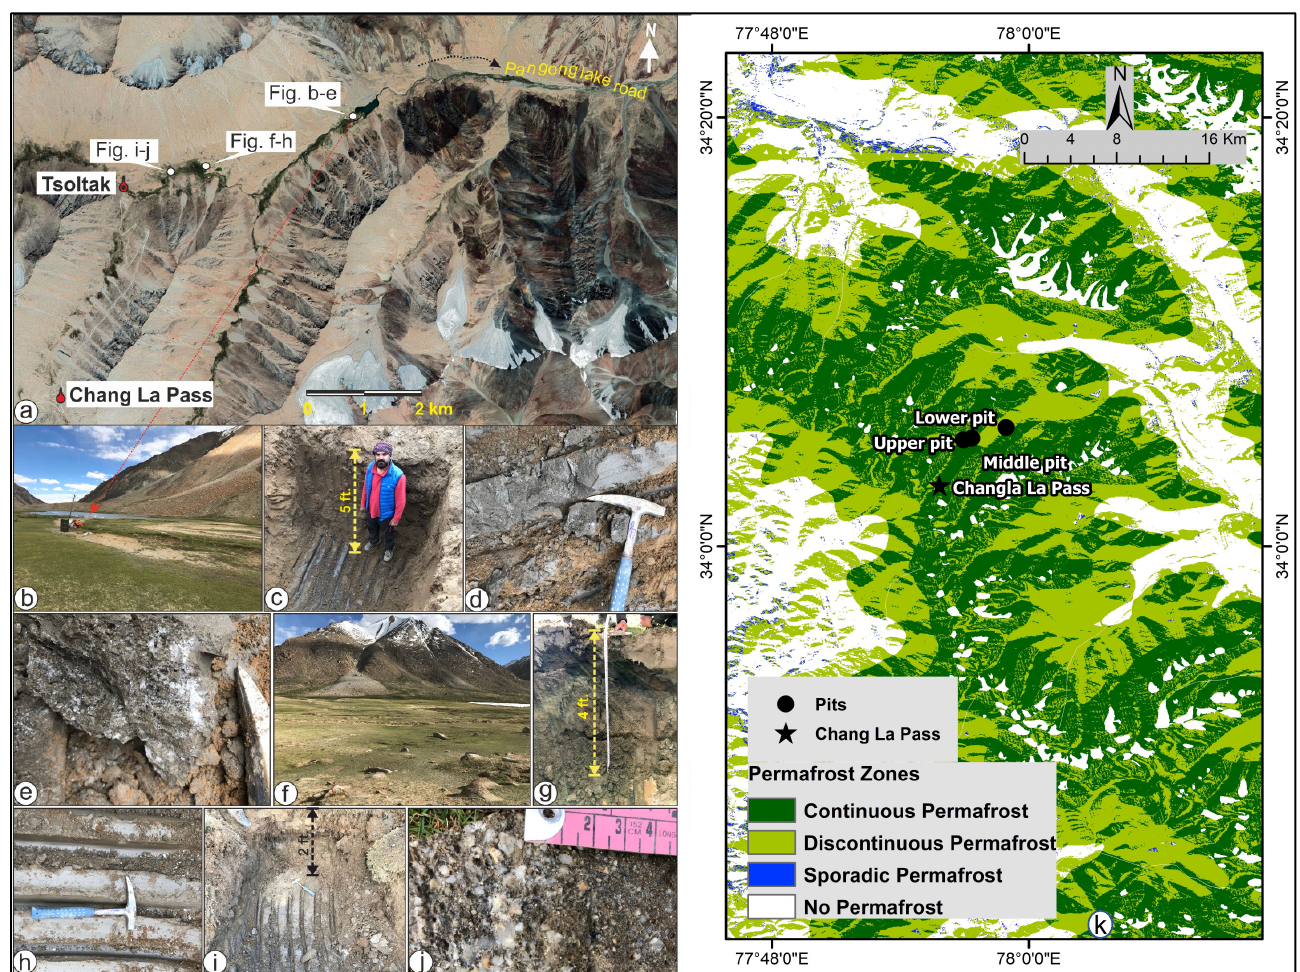
Figure 6. ( a ) Google Earth Pro image showing the location of pits excavated on the north slope of Chan La pass, ( b – e ) field photographs showing the pit site (~4838 m asl), permafrost depth, permafrost surface, and ice crystals respectively, ( f – h ) field photographs of the second pit (~4970 m asl) showing the synoptic view of pit site, permafrost depth and permafrost surface, and ( i – j ) field photographs of the third pit (~4990 m asl) showing permafrost depth and ice crystals, and ( k ) permafrost zone classification in the area.